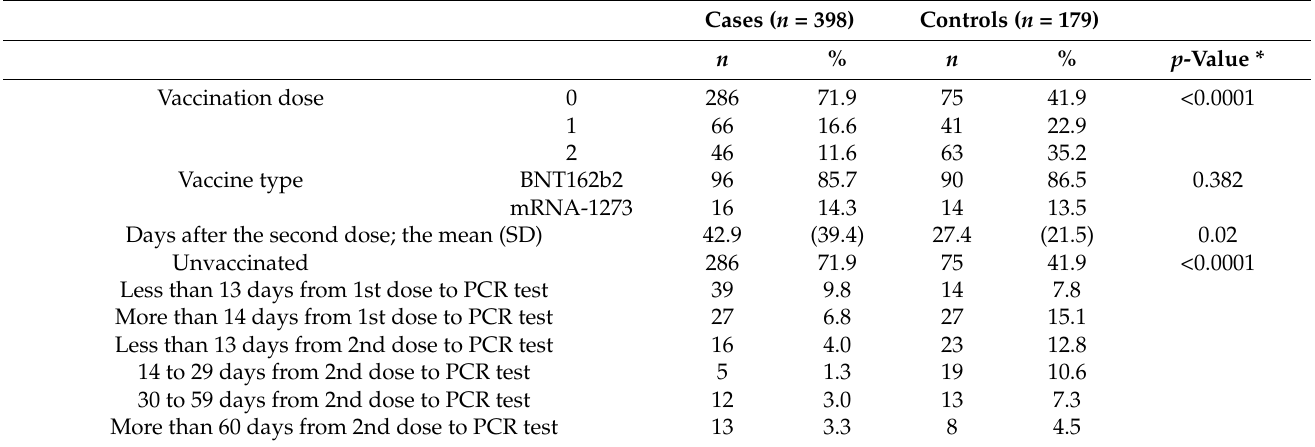
Table 2. Vaccination status.